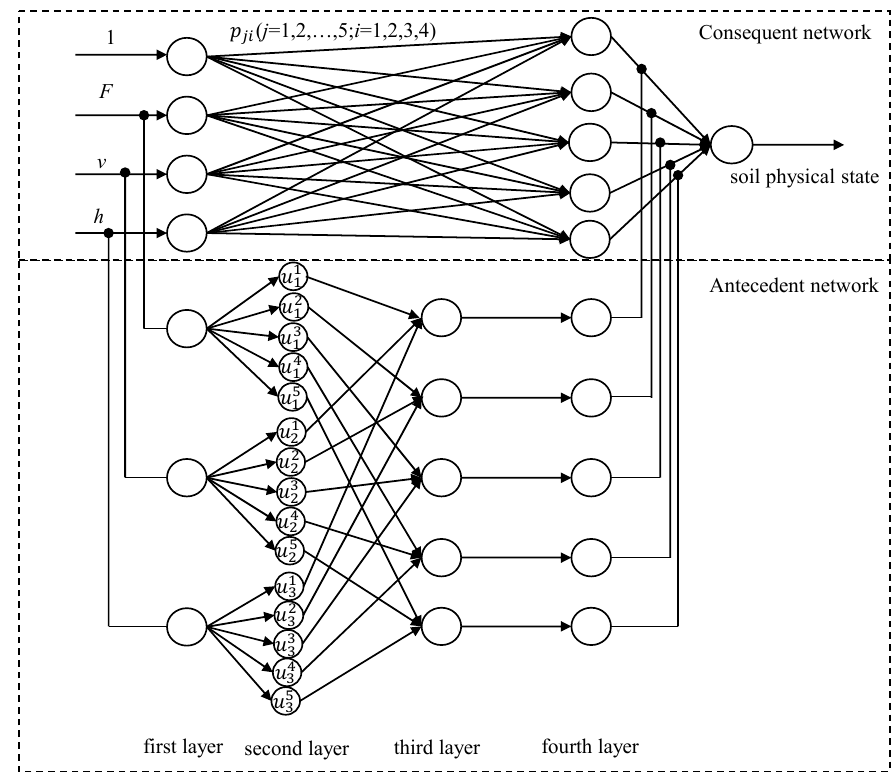
Figure 2. Structure of the soil physical state perception model.